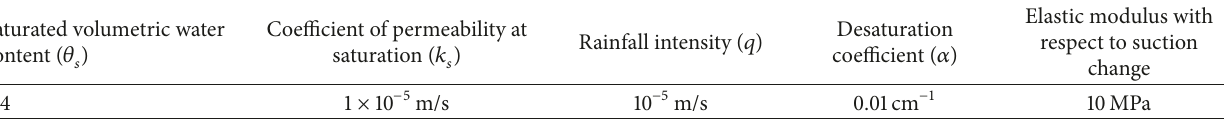
Table 1: The parameters used in analytical solutions to 1D unsaturated infiltration.